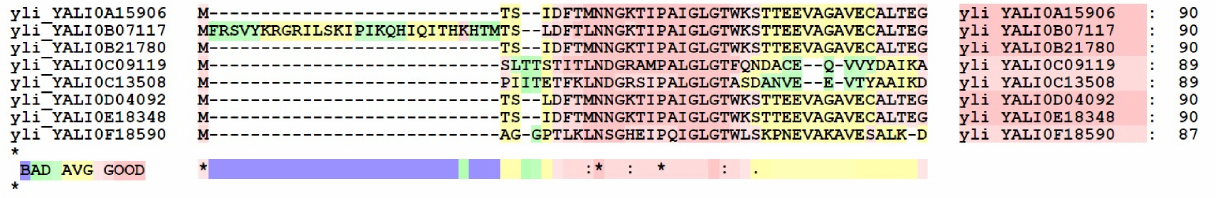
Figure 2. N-terminal fragment protein sequence alignment (T-COFFEE, Version 11.00). The colors indicate the level of homology: purple—low level of homology; yellow—average level of homology; red—high level of homology. The most conserved amino acids are additionally labeled with the * symbol. The lowest homology is observed within the first 30 amino acids of the N-terminal end, in which YALI0B07117g possesses a 28 amino acid sequence that is not present in other ER